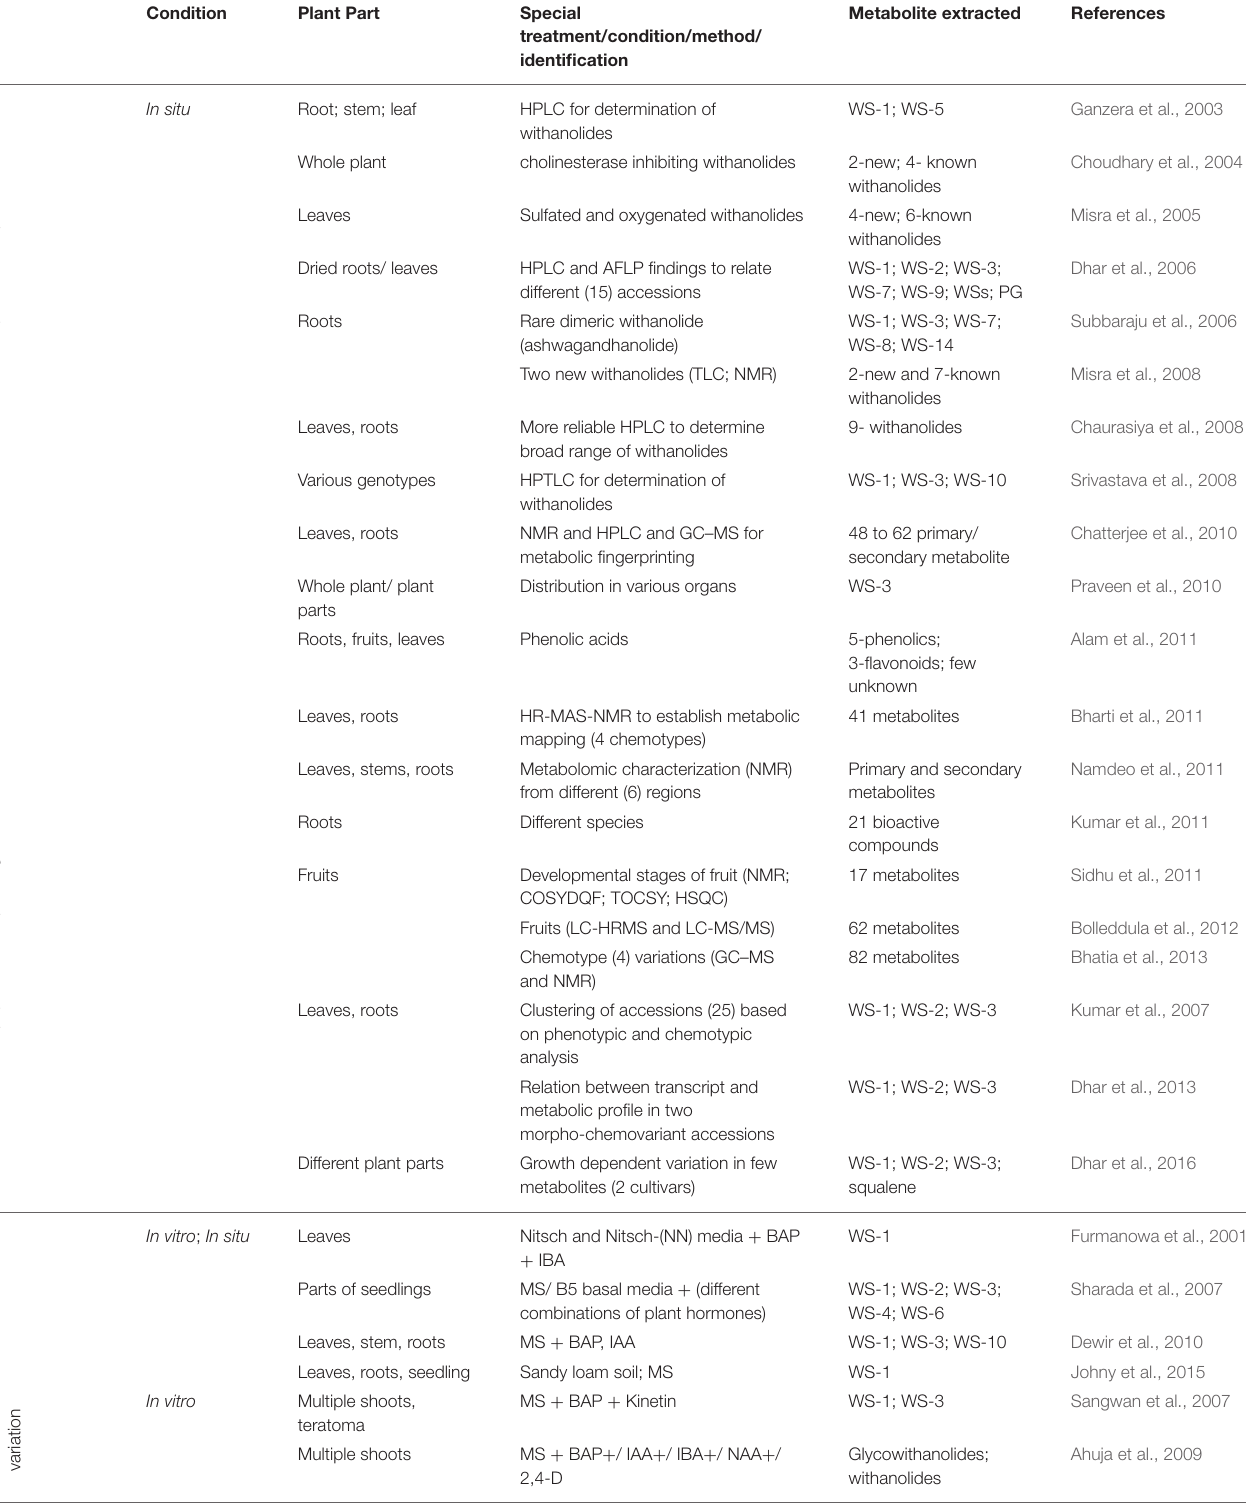
TABLE 1 | Different conditions/situation in order to accumulate therapeutically important metabolites of W. somnifera.